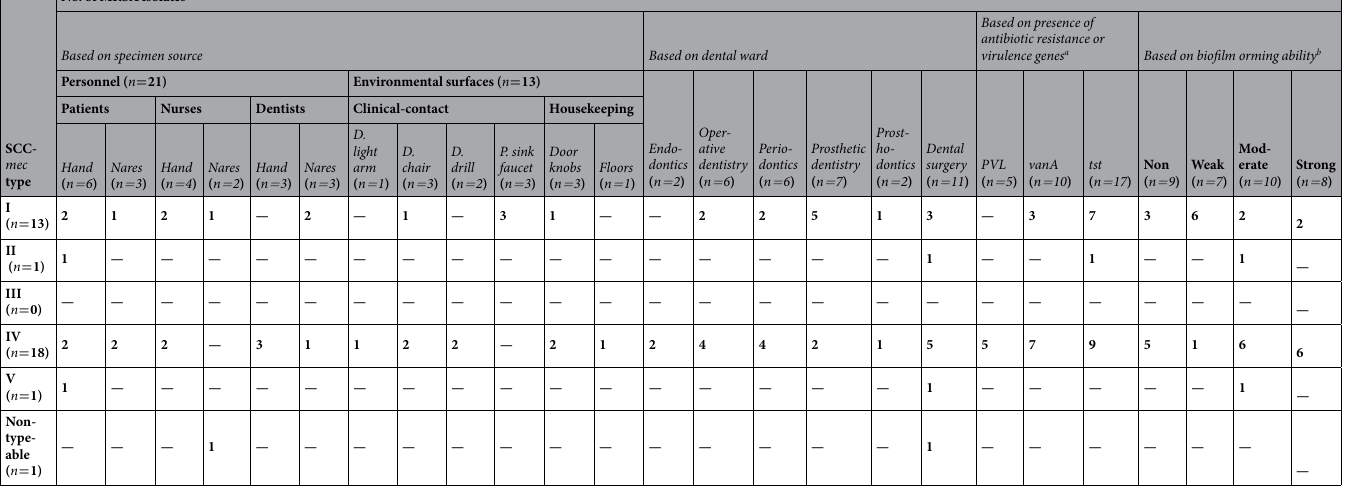
Table 6. Characteristics and detailed distribution of the SCCmec types detected in this study. SCC mec : staphylococcal cassette chromosome mec ; Non-typeable: an isolate with no PCR product obtained, or not in agreement with the predicted band patterns of SCC mec types I-V by the multiplex PCR method used; D light arm : Dental light arm; D chair : Dentist’s chair; D drill : Dentist’s drill; P sink faucet : Patient’s sink faucet; PVL : The gene encoding the Panton–Valentine leucocidin toxin; vanA: the gene encoding an enzyme that causes a structural change in the terminal amino acid of the pentapeptide chain of peptidoglycan, thus conferring vancomycin resistance; tst : the gene encoding the toxic shock syndrome toxin; spa: staphylococcal protein A; a minus sign ( − ) denotes the absence of an attribute. a All the MRSA isolates investigated in the current study were mecA- positive and mecC- negative. b The isolates were classified as biofilm non-producers, weak, moderate, and strong biofilm producers based on previously published criteria 34 .